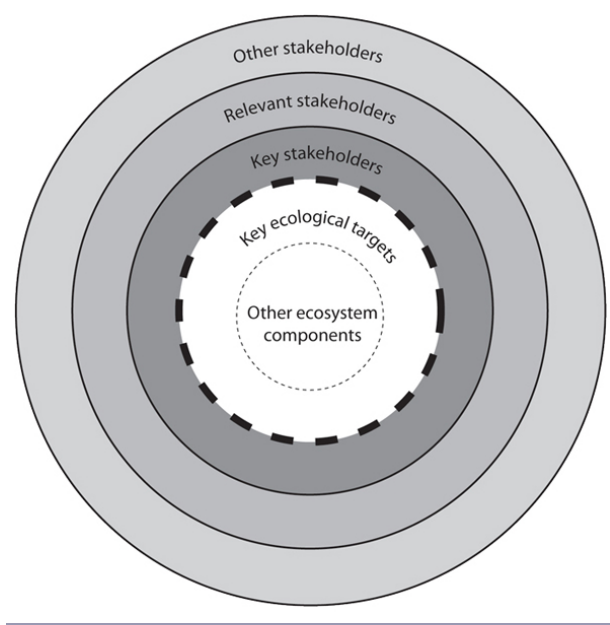
Fig. 3 . Subdivision of the social and ecological systems into key, relevant, and other components. Marine Protected Area Authorities (represented by the dashed line) can act on key social and ecological targets to promote improvement within both